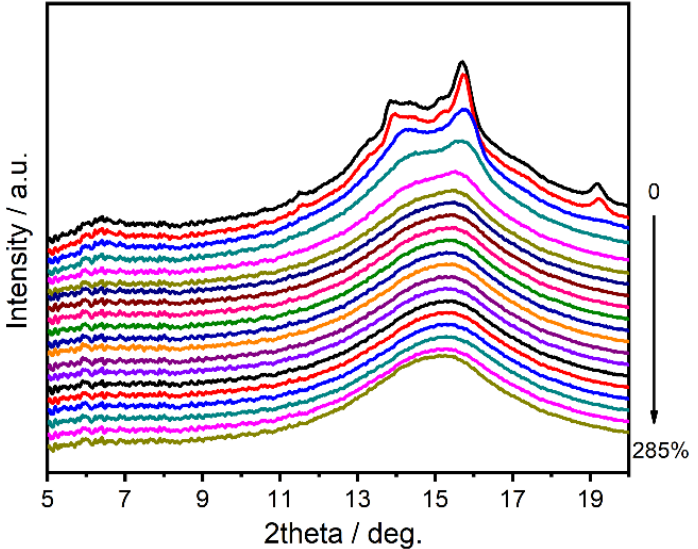
Figure 8. 1D-integrated WAXD curves in the meridional direction of PAPACM12.